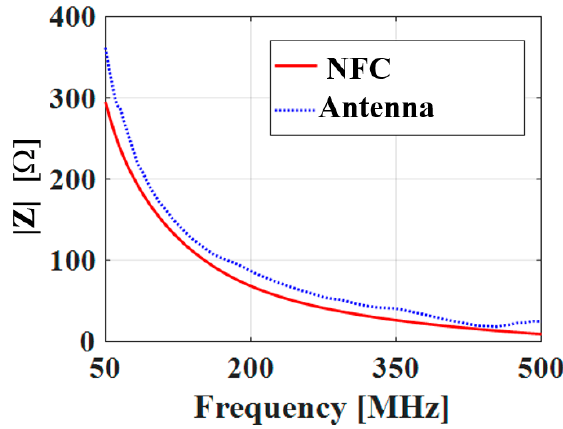
Figure 5. A comparison of the magnitudes of the antenna and non-Foster circuit impedance to check the open-circuit stability criterion.